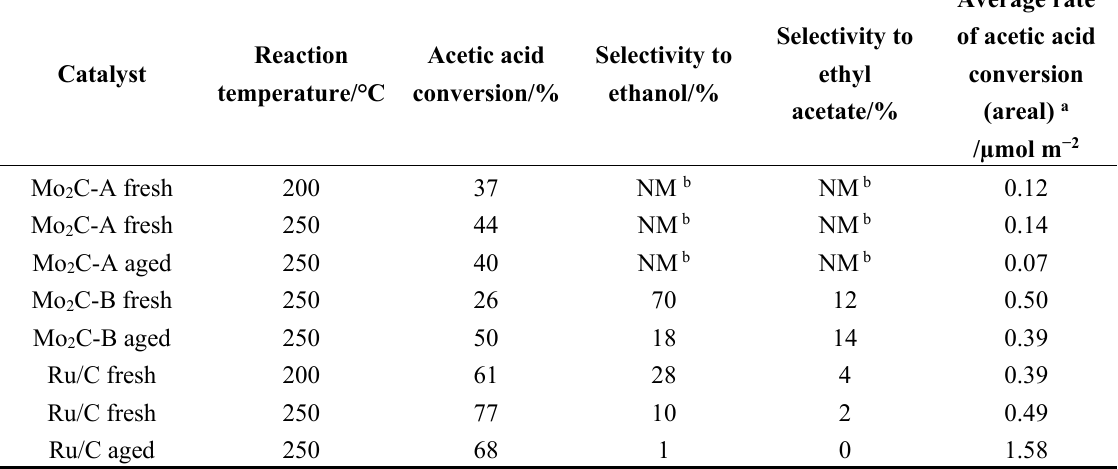
Table 3. Catalyst performance in aqueous-phase hydroprocessing of acetic acid; catalyst loading: 0.25 g, reaction mixture: 25 g of 10% ( w / w ) solution of acetic acid in water, reaction pressure: 2000 psig, stirring speed: 1000 rpm, reaction duration: 4 h.